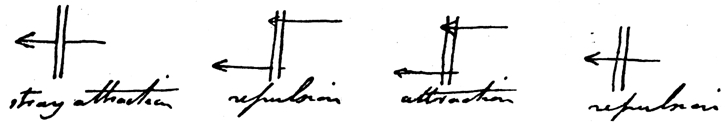
 The needle is construed as moving toward and away from the wire.